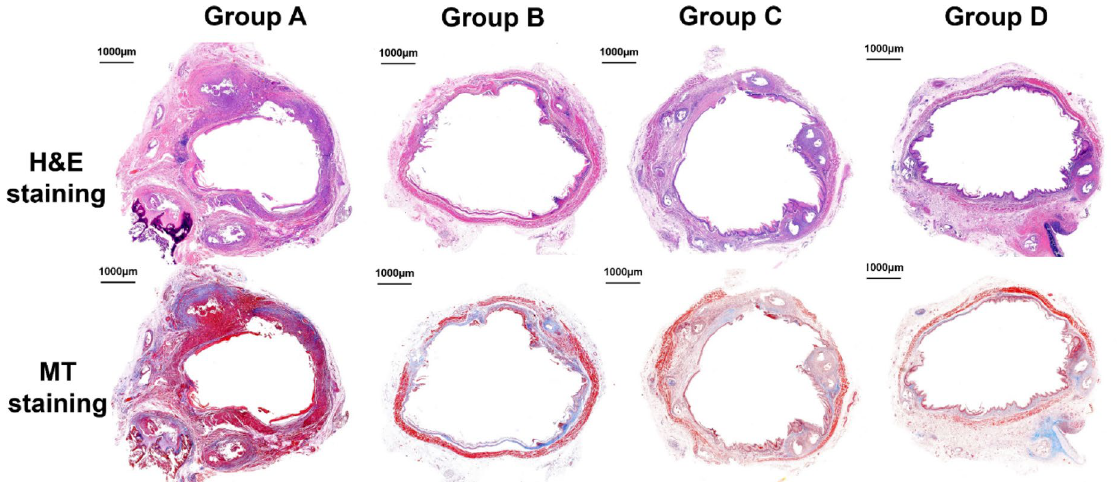
Figure 3. Representative microscopic images of histological sections obtained at 4 weeks (groups A and B ) and 8 weeks (groups C and D ) after stent placement. Hematoxylin and eosin and Masson’s trichrome stained sections are shown (magnification, × 1.25).